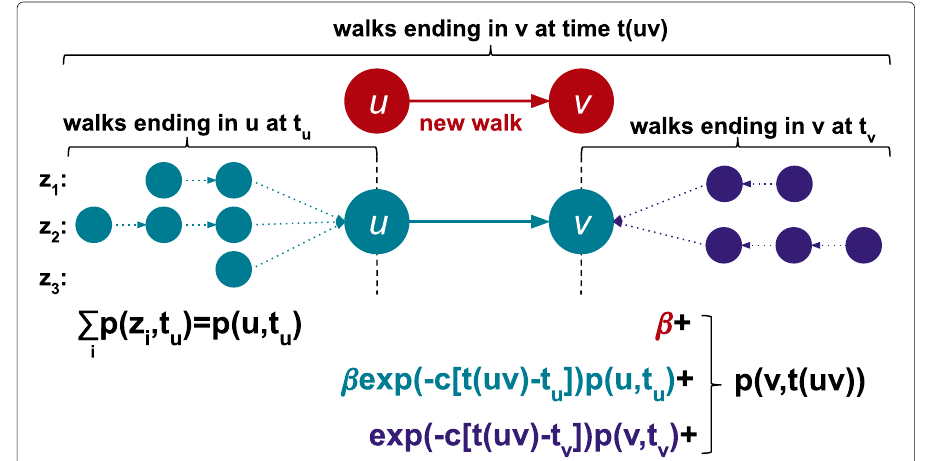
Fig. 5 Whenever a new edge uv appears, a new walk starts from u (red), and each temporal walk ( z 1 , z 2 , z 3 ) that ended in u up to time t u continues via uv (blue). We get p ( v , t ( uv )) by summing up the contribution of the previous two type of walks (red and blue) with the decayed weight of walks that have already reached node v (purple) before time t ( uv